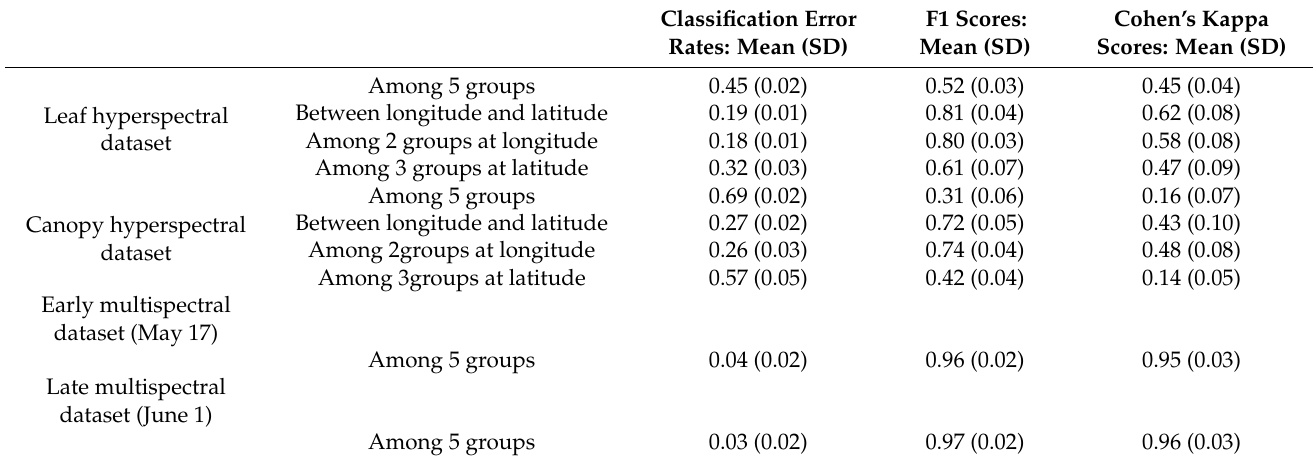
Table 4. Classification performance of random forest models based on different spectral